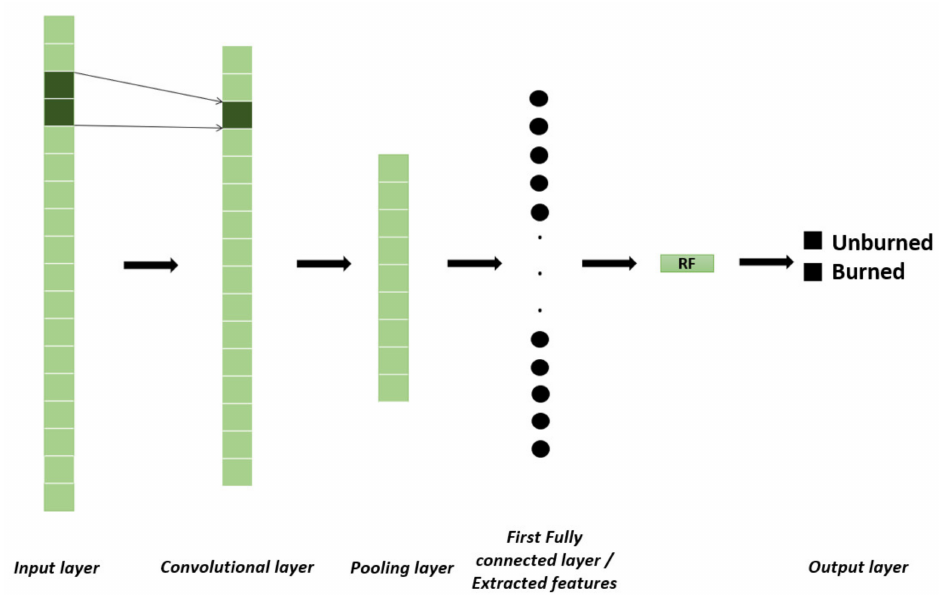
Figure 6. The architecture of a hybrid of CNN and RF method